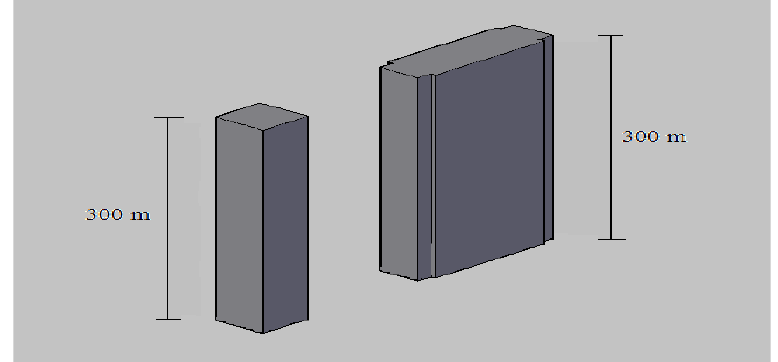
Fig. 2. Isometric view of the building